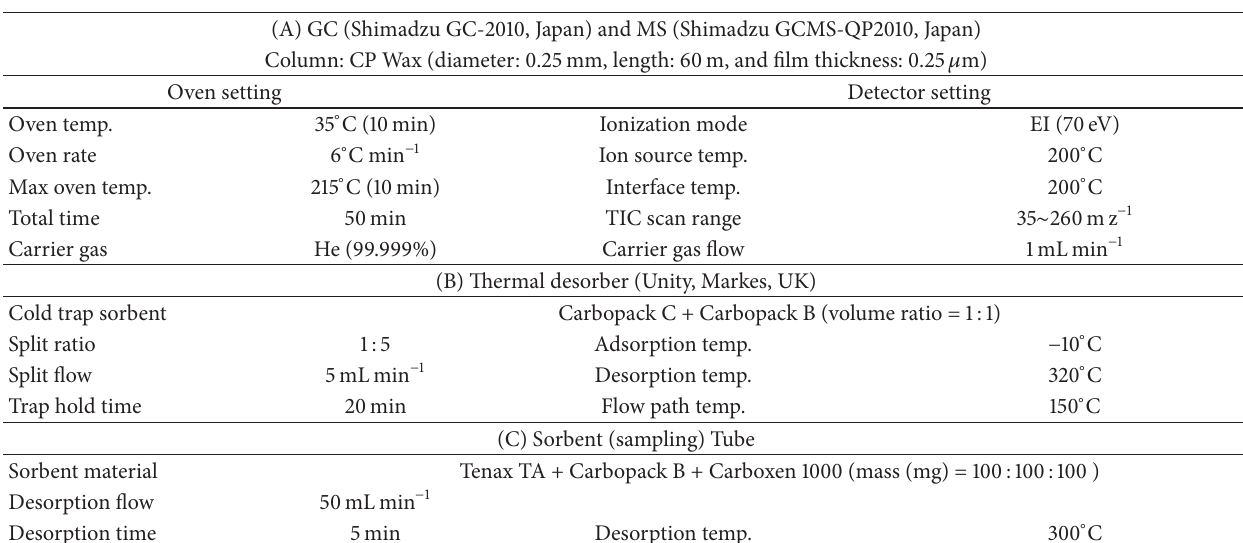
Table 3: Operational conditions of the TD-GC-MS system for the analysis of reference VOCs in this